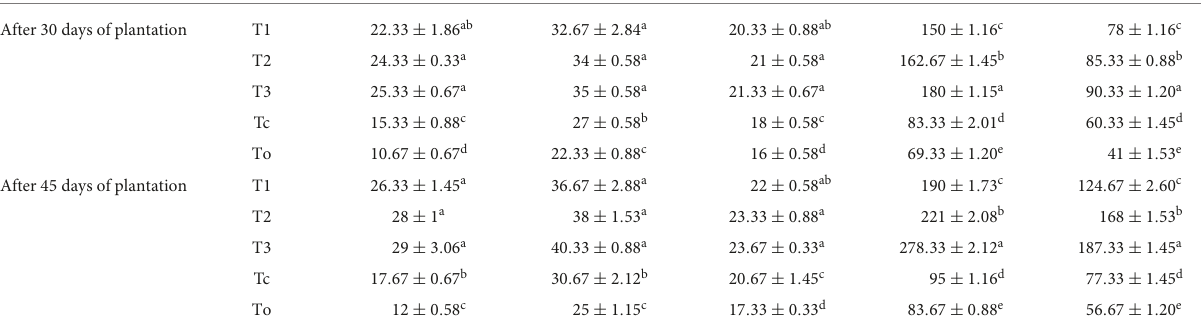
TABLE 2 Effect of bacterium and fertilizer in different time period among different treatment group.